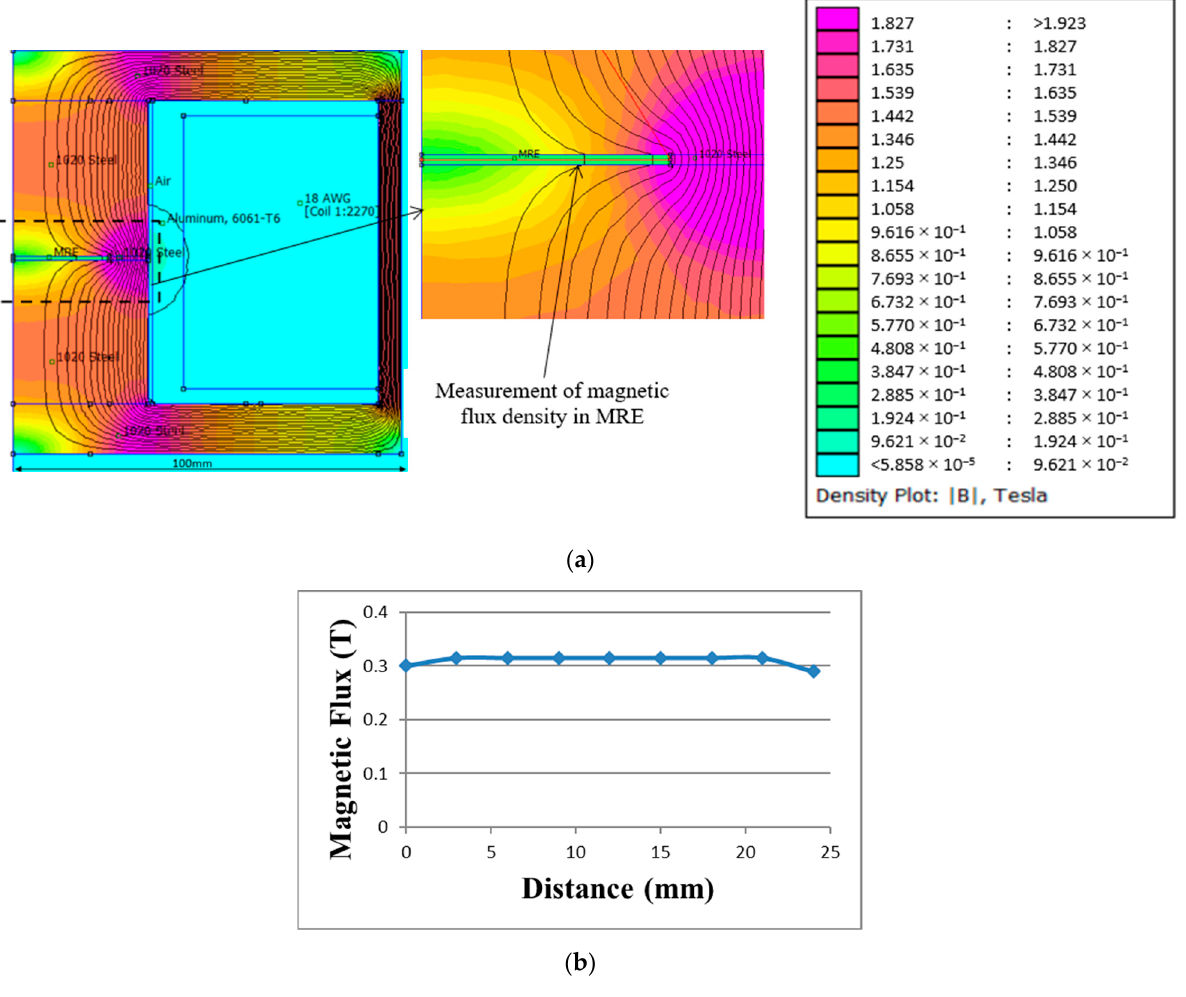
Figure 2. Simulation of magnetic flux density using FEMM: ( a ) distribution and ( b ) the value of magnetic flux across the MRE sample.